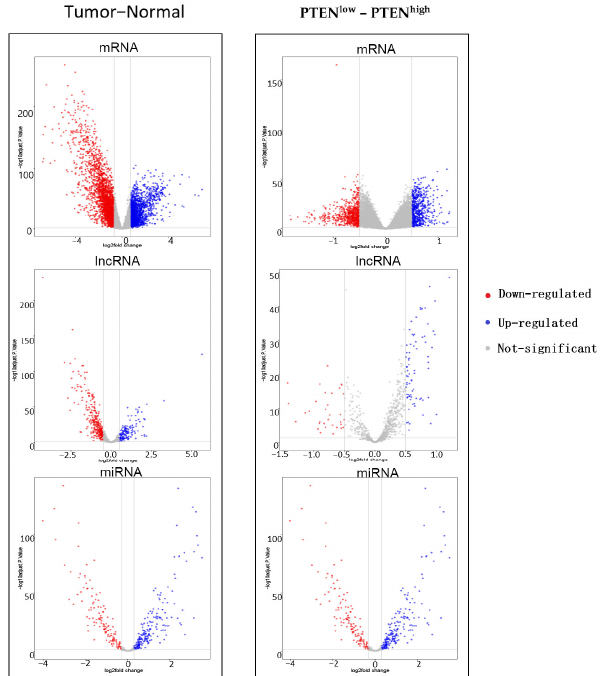
Figure 3. Volcano plots of demRNAs, delncRNAs, and demiRNAs between the expression of tumor and normal group as well as PTEN low and PTEN high group: Red denotes down-regulated RNAs and blue represents up-regulated RNAs.